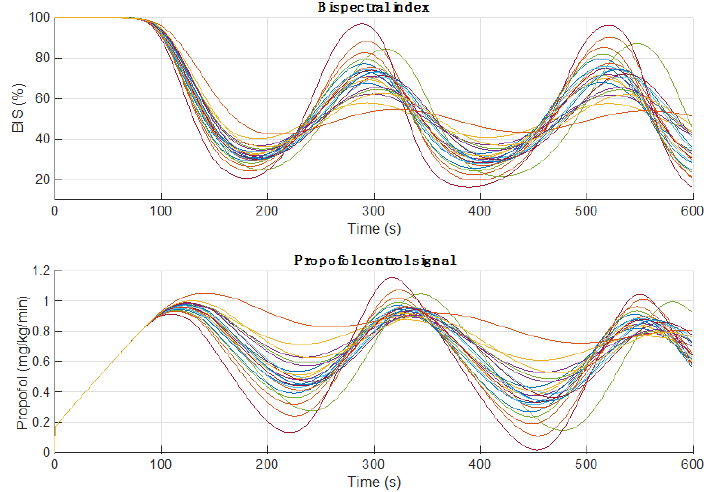
Figure 20. BIS response and Propofol control values for the 24 patients considering a 60 s dead time in all cases.